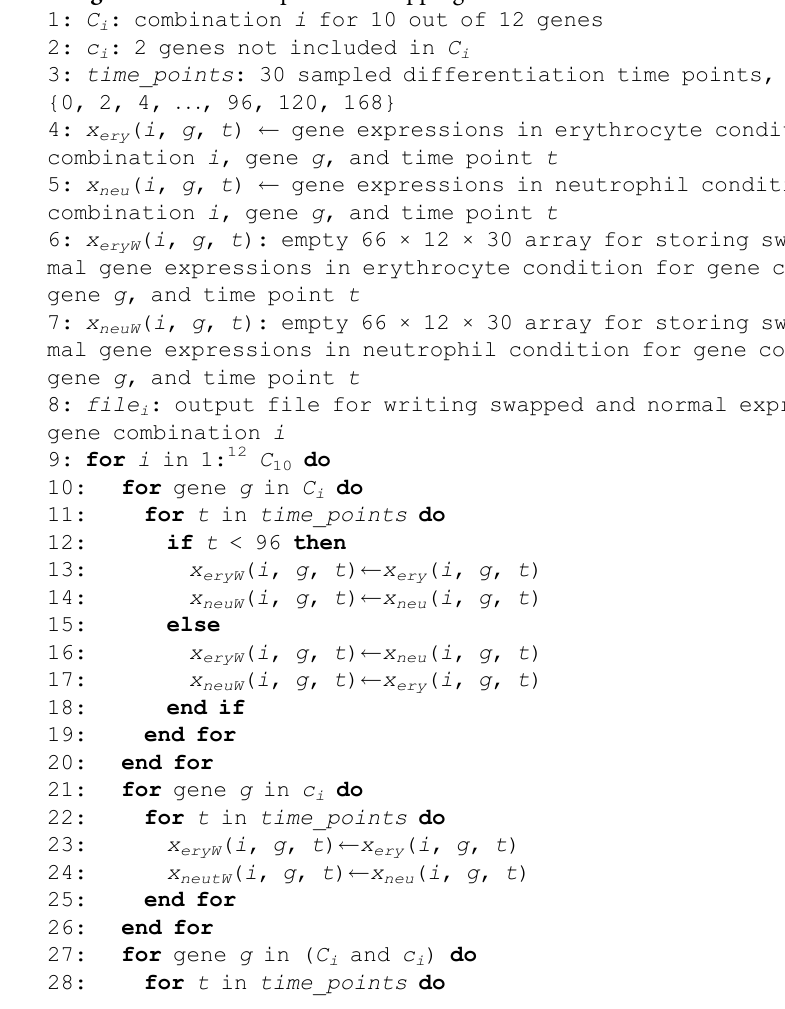
Algorithm 1 Gene expression swapping between two